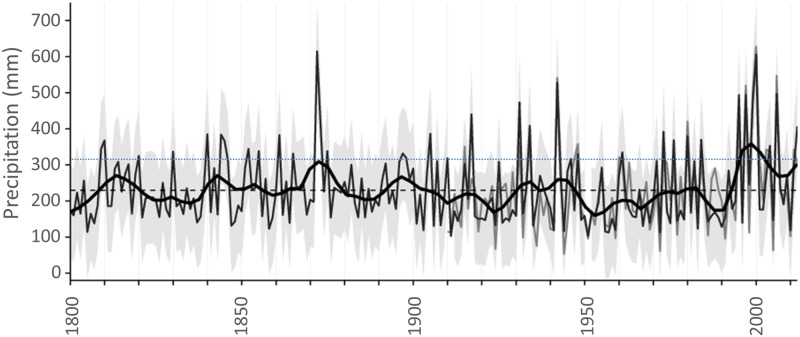
Temporal variability of summer-autumn precipitation in semi-arid northwest Australia over the last two centuries.Observed precipitation is shown by the mid-grey line and reconstructed precipitation is shown by the dark grey line. A 20-year loess smoothing curve is shown by the solid black line; the long-term (1802–2012) mean is shown by the dashed black line; 95% prediction intervals (fitted with the predict function in R 3.1.0) are indicated by light grey shading. The dotted blue line indicates where scPDSI is equal to zero and highlights the recent period (1995–2002) when scPDSI was greater than zero.